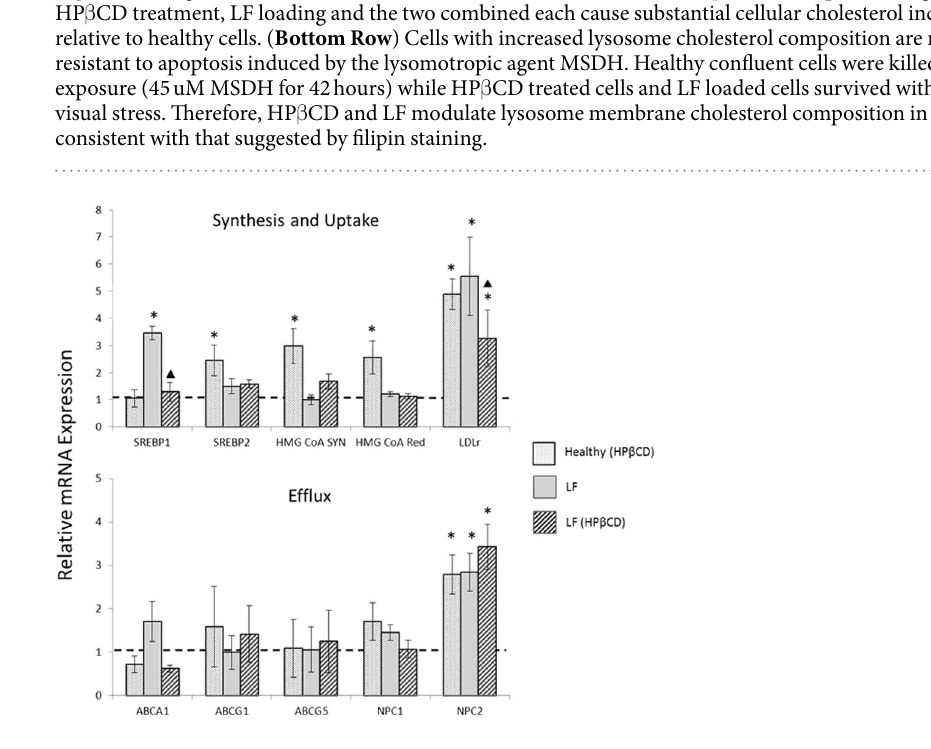
The observed cholesterol increases associated with LF loading coincide with overexpression of SREBP1 and LDLr (Fig. 3). Cholesterol biosynthesis (in the form of SREBP2, HMGCR, HMGCS ) was not activated. The addi- tion of HP β CD to LF-loaded cells completely attenuated SREBP1 overexpression back to control levels (from 3.5 to 1.3, P < 0.001), while LDLr expression was reduced by about 40% from 5.6 to 3.3 (P < 0.04). Finally, the choles- terol increases observed in HP β CD-treated healthy cells came from upregulation of both cholesterol biosynthesis and uptake genes. Specifically, SREBP2, HMGCR and HMGCS were all upregulated 2.5–3-fold (P < 0.001), while LDLr was upregulated nearly 5-fold (P < 0.001, Fig. 3). The expression of efflux genes remained unaffected for all test conditions, except for NPC2. However, since NPC2 was upregulated for all three test conditions (Fig. 3), we conclude that this is cholesterol-driven rather than an HP β CD-driven response.